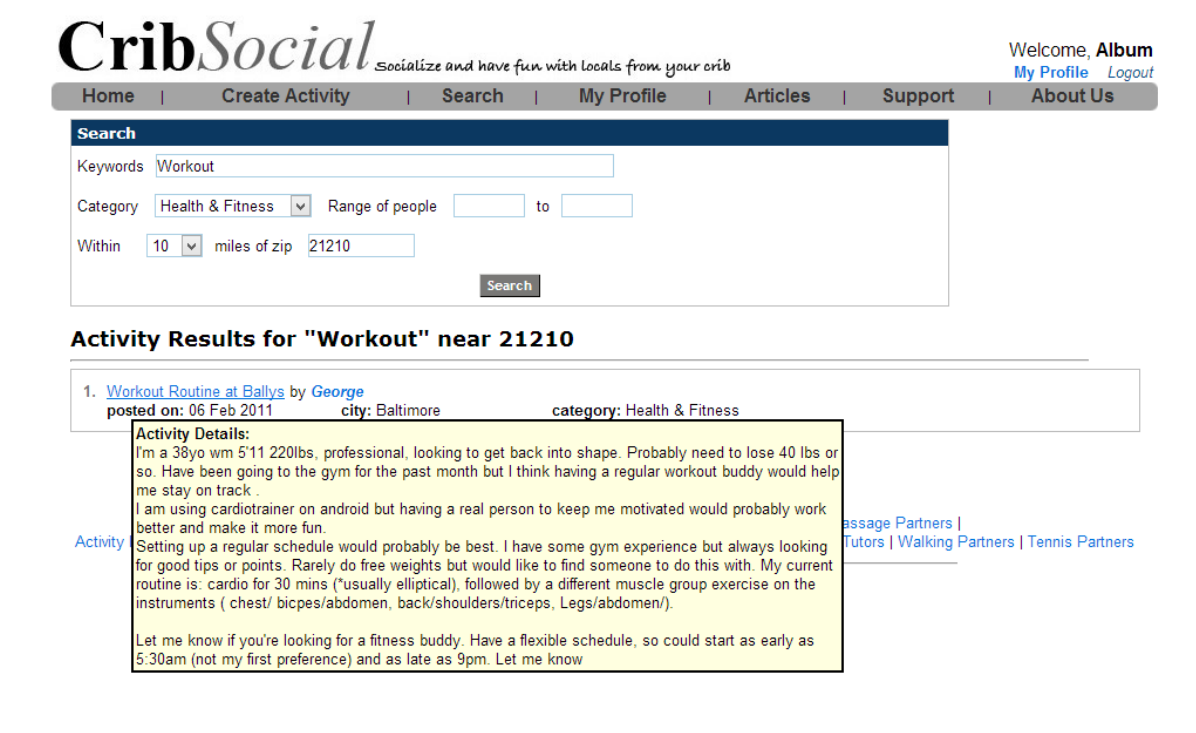
Figure 3. CribSocial: Filtering